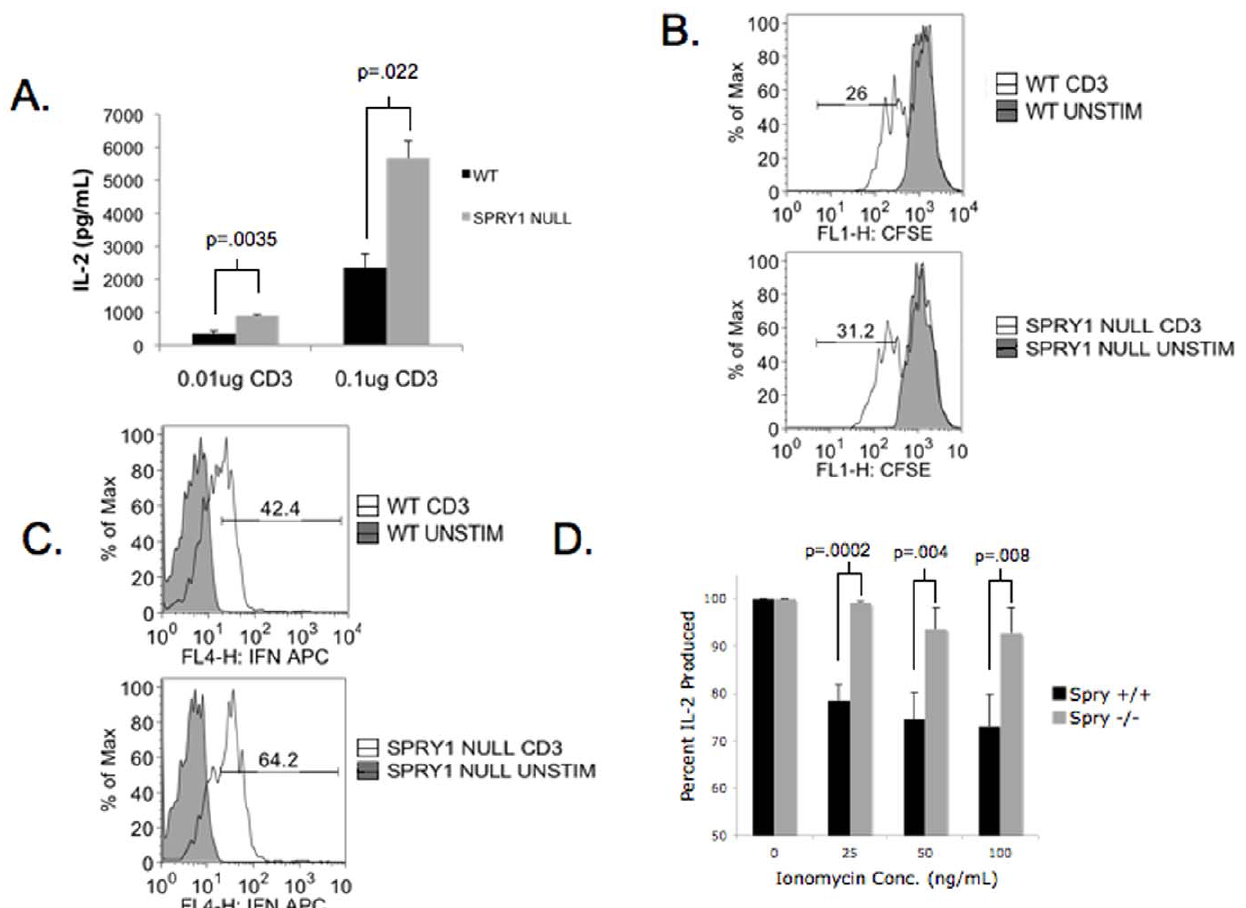
Figure 3. Spry1 null CD4 + T cells have enhanced effector function. Spry1 null and wild type spleens were expanded in vitro with anti-CD3; CD4 + T cells were isolated and rechallenged with increasing doses of anti-CD3. A. IL-2 production by CD4 + T cells was determined by ELISA. B. CFSE dilution of CD4 + wild type and Spry1 null CD4 + T cells. C. IFN c production was determined by intracellular cytokine secretion assay. % of Max indicates the fraction of the total cells at a given fluorescent intensity. D. Following expansion Spry1 null and wild type spleens were stimulated with increasing doses of ionomycin, briefly rested and rechallenged with anti-CD3. Resistance to ionomycin-induced anergy is displayed as percentage of IL-2 produced following ionomycin treatment and rechallenge compared to rechallenged alone. Error bars represent one standard deviation of the mean. P values indicate statistical significance by student t-test. All experiments were performed at least three times. Data are representative of 3 mice per